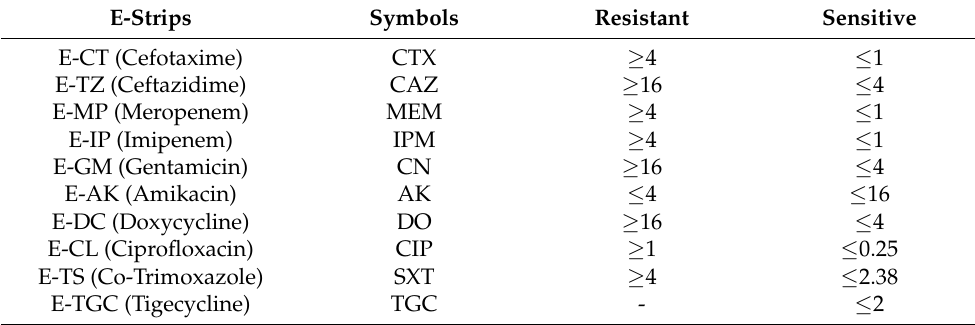
Table 11. E-strips used in the current study for determination of